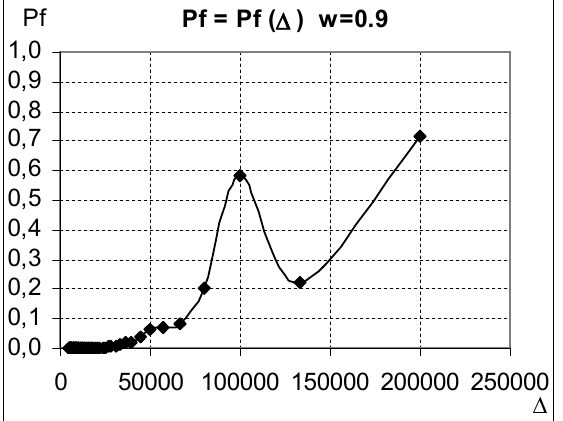
Fig 6. Failure probability in the case of m ≠ 2 for the corroded specimens with specified life = 400000